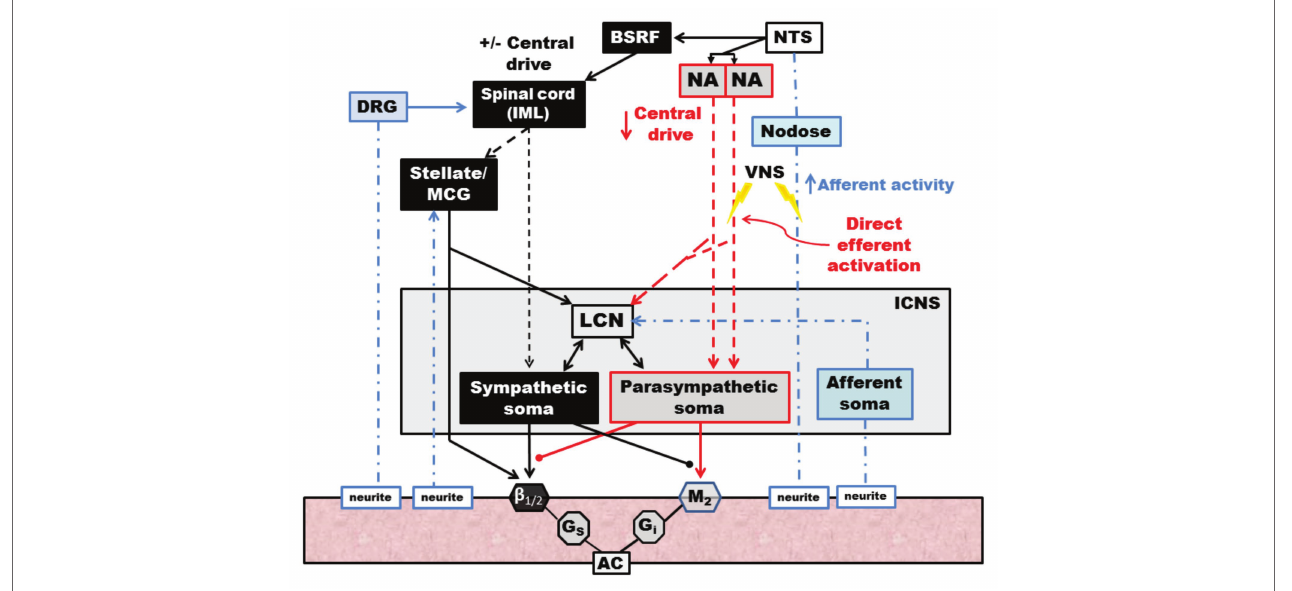
FIGURE 9 | Schematic diagram of the effects of vagal nerve stimulation on the cardiac neuraxis. Direct efferent activation of the vagus nerve results in activation of parasympathetic postganglionic cells, located in the ICNS, which act on muscarinic receptors on the myocardium. LCNs within the ICN are activated, which modulate sympathetic reflexes with input from afferent soma, ultimately blunting reflexes within the ICNS. Afferent activation results in reduced central drive and modulates projections to spinal sympathetic networks. Sympathetic spinal reflexes are also blunted via inhibitory projections (not shown). NTS, nucleus tractus solitarus. NA, nucleus ambiguus. BSRF, brain stem reticular formation. VNS, vagal nerve stimulation. DRG, dorsal root ganglia. IML, intermediolateral nucleus. MCG, middle cervical ganglia. LCN, local circuit neuron. ICNS, intrinsic cardiac nervous system. AC, adenylyl cyclase. Adapted from Ardell et al.